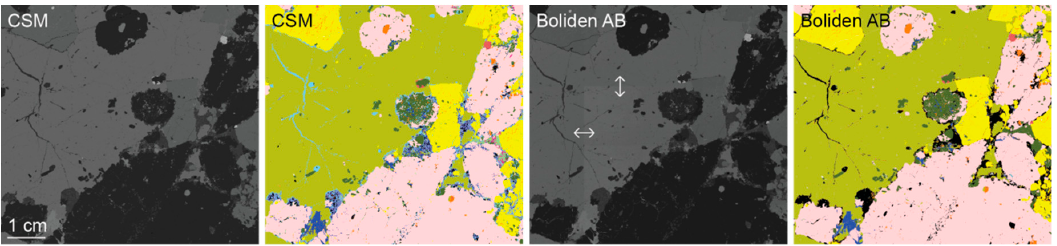
Figure 5. BSE image and corresponding mineral map of a part of the thin section analyzed in this study for CSM (left) and Boliden AB (right). A grey-level shift in the BSE image of Boliden AB can be observed (indicated by arrows). This shift was not observed for CSM and is not reflected in the mineral map.